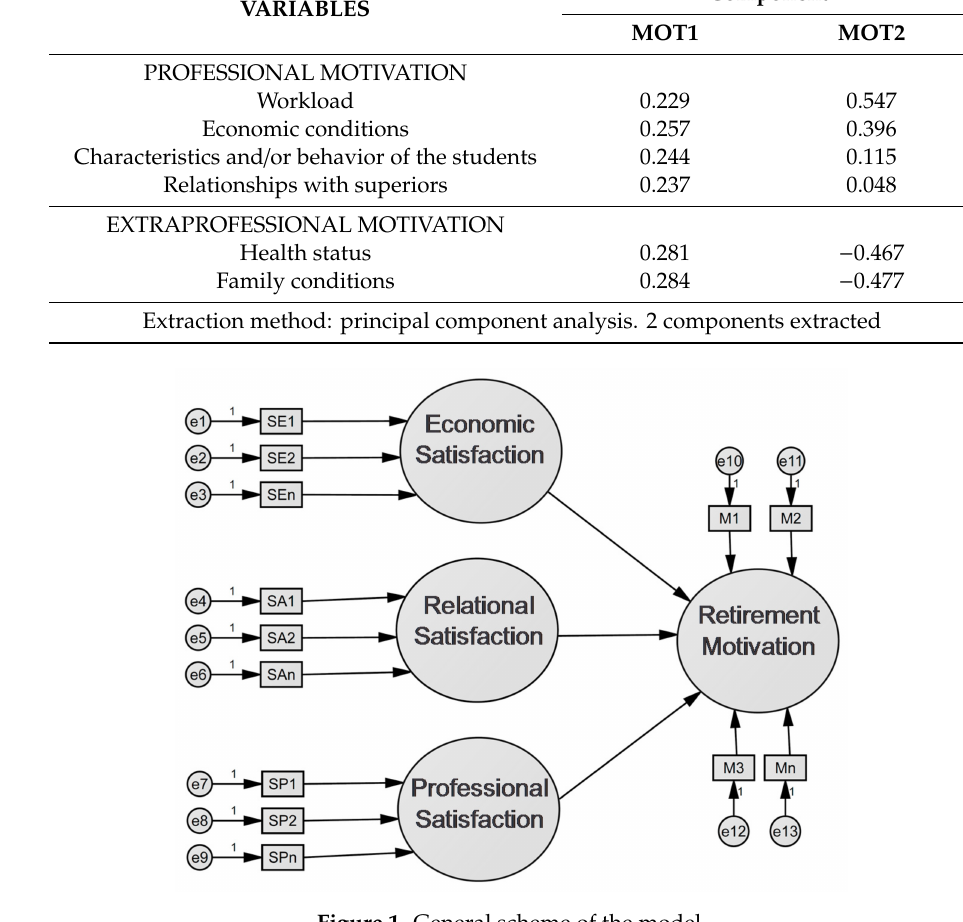
Figure 1. General scheme of the